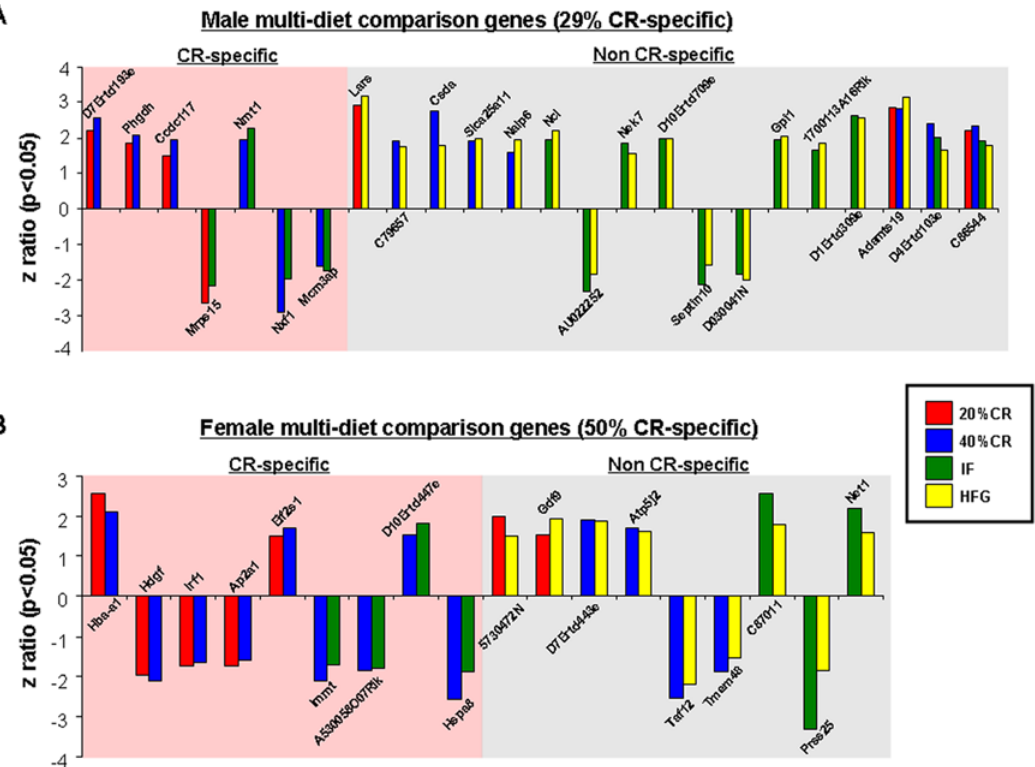
Figure 7. Caloric specificity of male and female multi-diet regulated genes. Significantly altered genes that were common between one or more of the diet paradigms are drawn to visualize caloric specificity. (A) Commonly altered genes in the testes of male rats on the various diets showed 29% caloric restriction (CR) specificity (commonly regulated between the 20% CR, 40%, CR, and/or IF diets only) and 71% non-CR specificity. (B) Commonly altered genes in the ovaries of female rats on the various diets showed 50% caloric restriction (CR) specificity and 50% non-CR specificity. Names of the significantly altered genes can be found in Table S1.